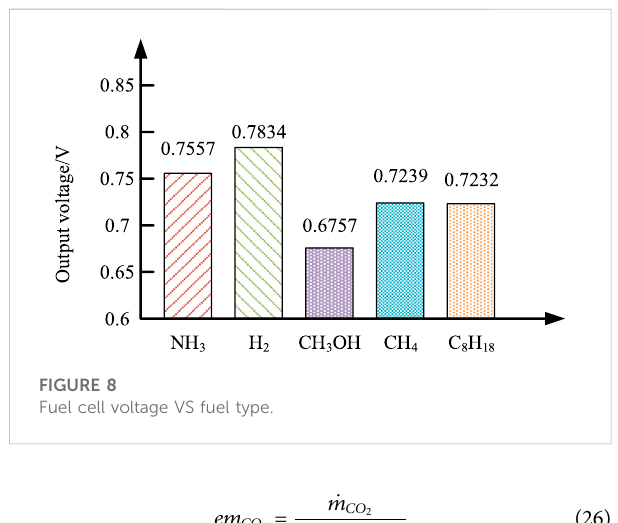
FIGURE 8 Fuel cell voltage VS fuel